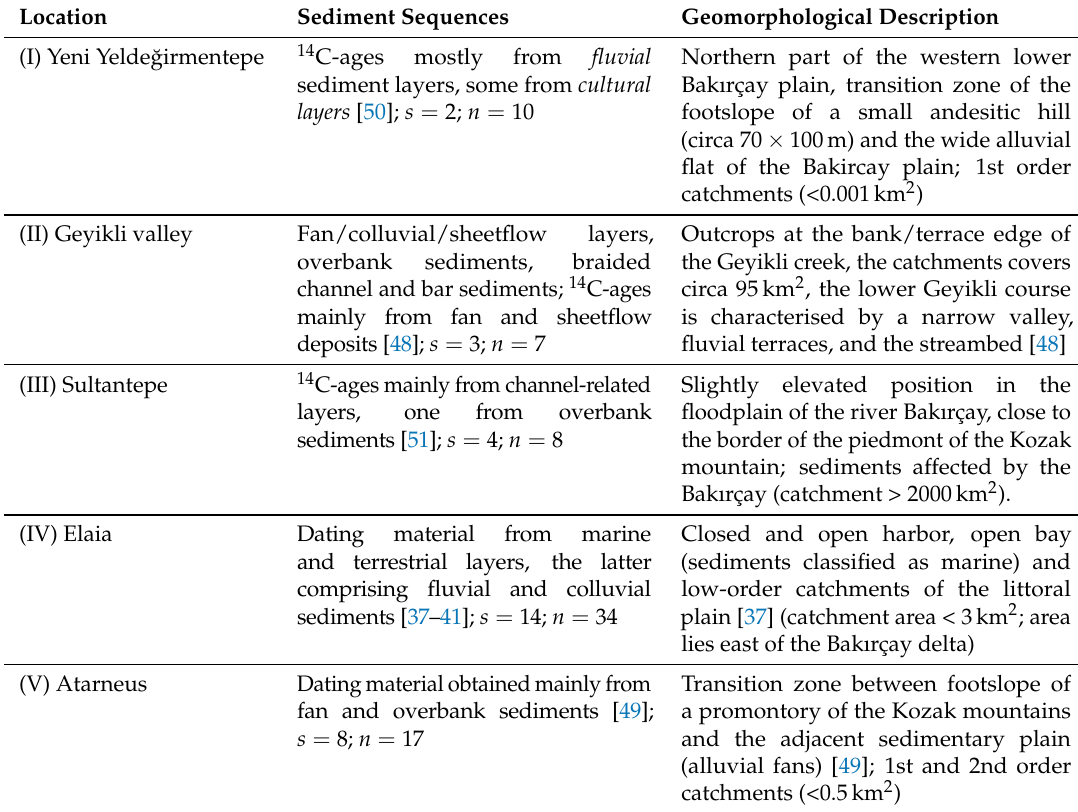
Table 1. Overview of the sediment sequences included in our meta-analysis. More details can be found in the Supplementary Materials and the original publications. The locations are shown in Figure 1. For n = 21 samples, no detailed information on sediment sequences and geomorphological setting is available. s = number of sediment sequences from location; n = number of 14 C-ages from